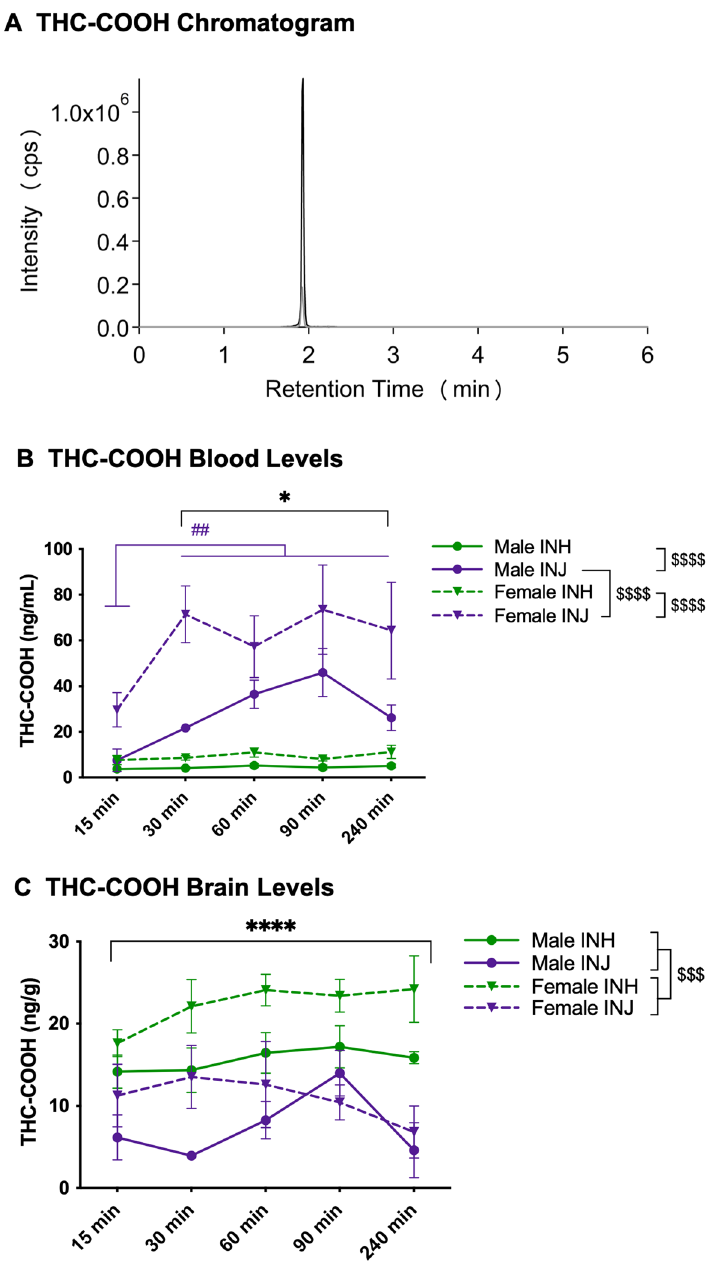
Figure 5. THC-COOH chromatogram and levels in blood and brain. ( A ) LC-MS Chromatogram: THC- COOH (black line) and THC-COOH-d3 (grey line) peaks at 2.0 min. ( B ) Blood levels: Data are presented as mean ± SEM; n = 5–6 for each group. Presence of (*) indicates an administration difference with INH < INJ at 30, 60, 90 and 240-min at * p < 0.05. Presence of ( # ) indicates a timepoint difference with purple lines indicating an INJ difference where INJ-15 < all timepoints at ## p < 0.01. Presence of ( $ ) indicates a sex difference; specifically, male-INH < male-INJ and female-INH < female-INJ at $$$$ p < 0.0001, and male-INJ < female-INJ at $$$$ p < 0.0001. ( C ) Brain levels: Data are presented as mean ± SEM; n = 5–6 for each group. Presence of (*) indicates an administration difference with INH > INJ at **** p < 0.0001. Presence of ( $ ) indicates a sex difference with males < females at $$$ p <